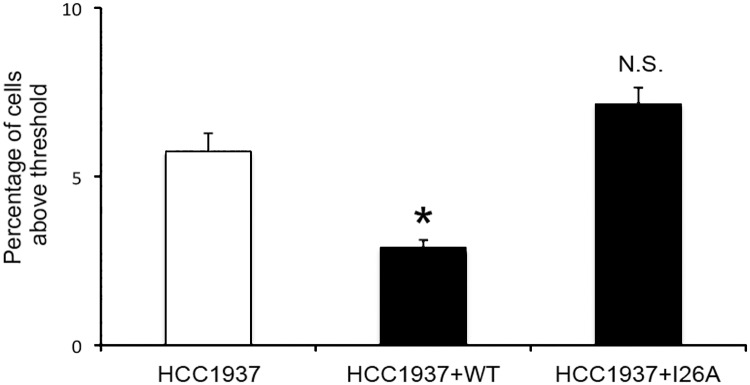
Analysis of T575 phosphorylation in human breast cancer cells.HCC1937, HCC1937 cells transfected to express full length functional BRCA1 (HCC1937+WT) and HCC1937 cells transfected to express BRCA1 harbouring a ubiquitin ligase-inactivating I26A mutation (HCC1937+I26A) were analysed for T575 phosphorylation by flow cytometry as described. There is a significant reduction in phosphorylation when WT BRCA1 function is restored in HCC1937 cells (p<0.05) but not when the cells express an inactive I26A BRCA1 (p = 0.1). Values represent mean +/- SEM of the percentage of cells with pT575 signal above a threshold determined by first antibody deletion controls.